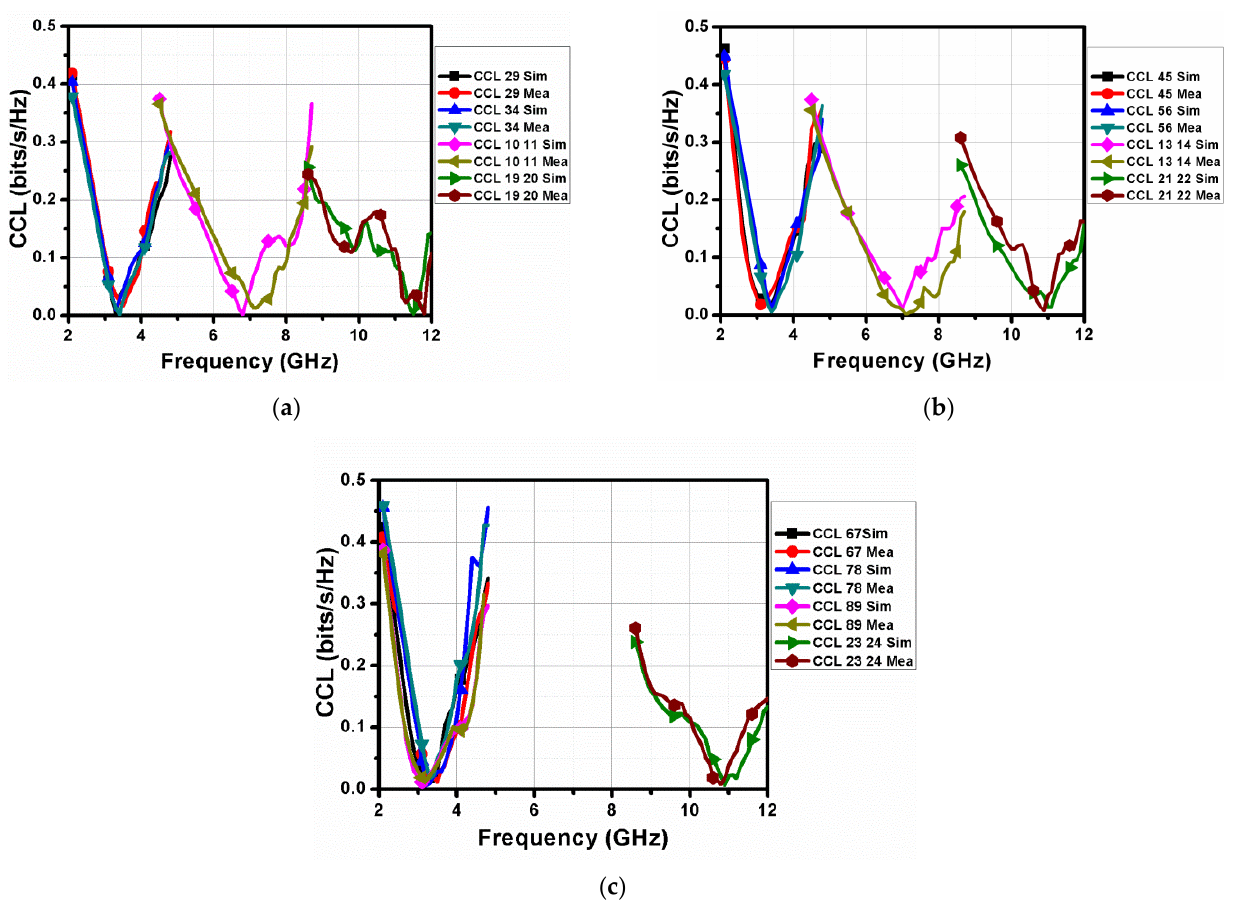
Figure 34. CCL of the 25-port CR MIMO antenna. ( a ) CCL 29, CCL 34, CCL 10 11 and CCL 19 20 ( b ) CCL 45, CC 56, CCL 13 14 and CCL 21 22 ( c ) CCL 67, CCL 78, CCL 89 and CCL 23 24